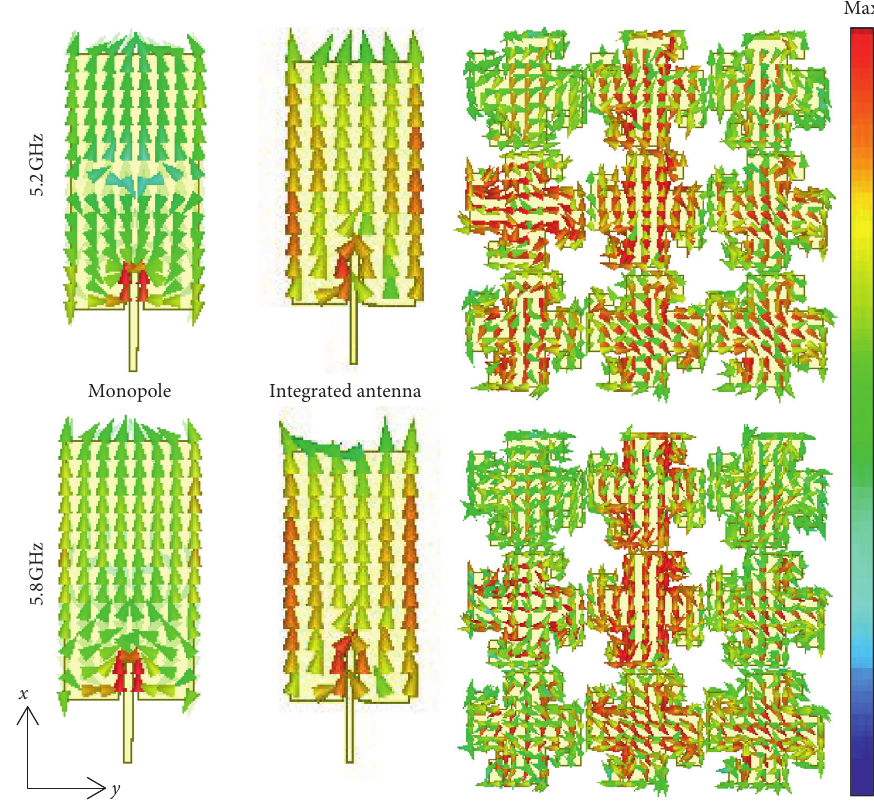
Figure 5: Surface current of the monopole and the integrated MSs antenna at working